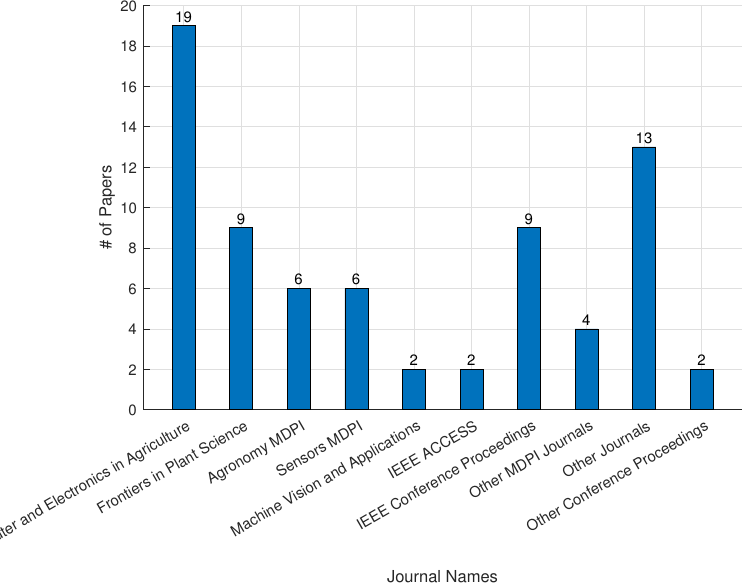
Figure 7. Publication distribution for deep learning applications in controlled environment agriculture.